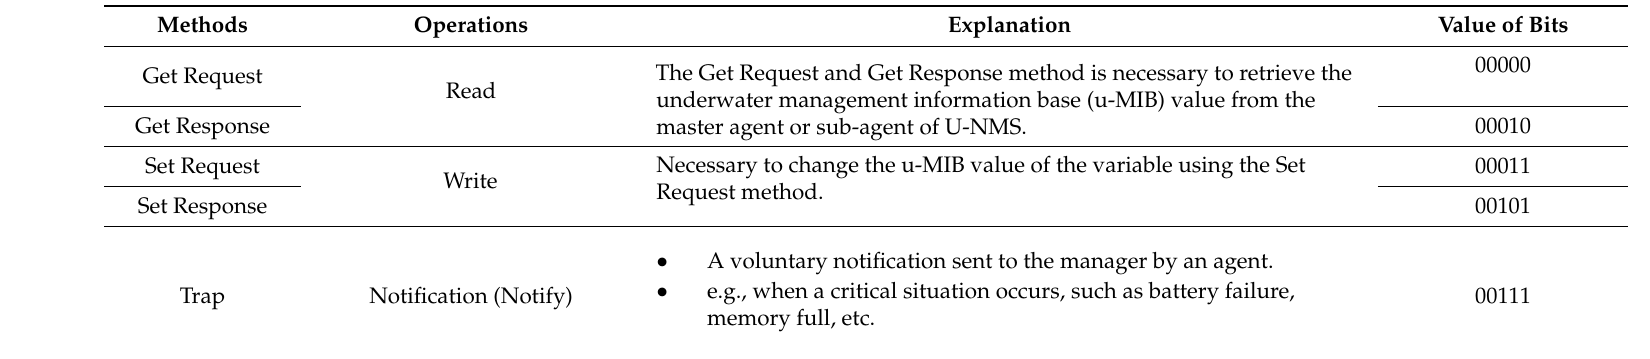
Table 2. Operations OF u-SNMP